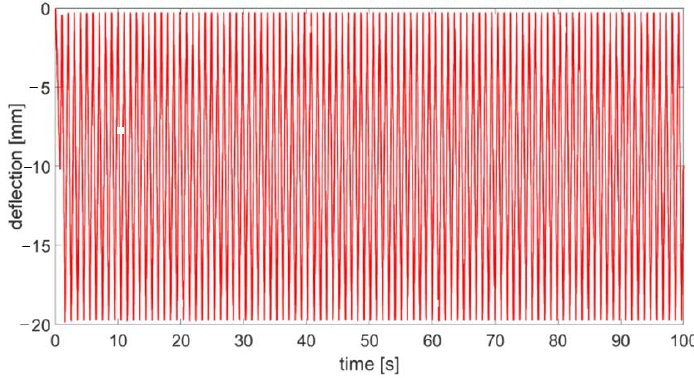
Figure 5 . An example of 100 compression cycles at 50% (20 mm) triangular course.